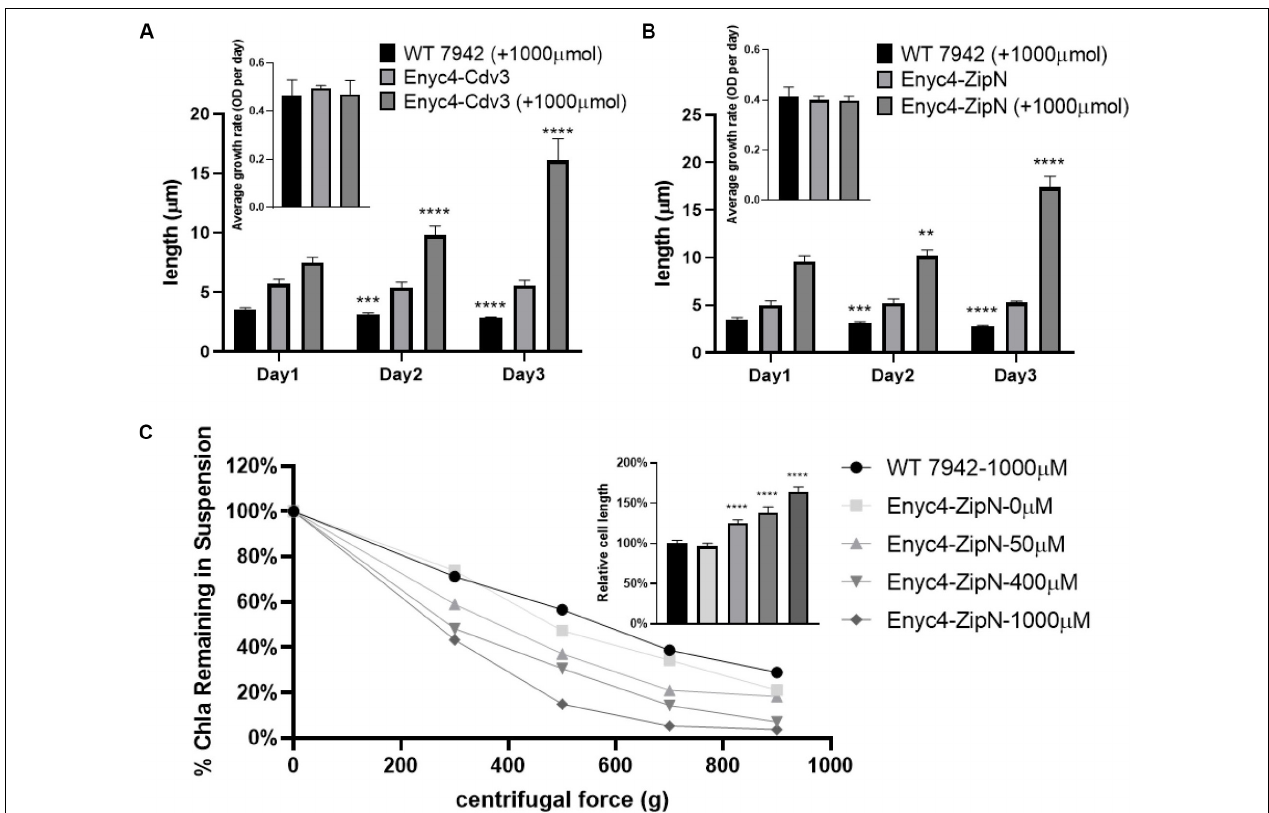
FIGURE 4 | Response of the cell lengths to theophylline induction in PCC7942 strains carrying riboswitch-regulated expression of Cdv3 and ZipN. The cell lengths of the PCC7942 mutants carrying Ptrc-ENYC4-Cdv3 (A) and Ptrc-ENYC4-ZipN (B) were calculated during 3 days cultivation with (1000 µ M) or without theophylline induction. The inset figures show the growth rates of the wild type and mutant strains during the process. The Kruskal-Wallis test in One-way ANOVA was used to analyze the significant difference of cell length at Day 2 (and Day 3) compared with that of at Day 1 in each strain. * indicates < 0.05; ** indicates < 0.01; *** indicates < 0.001; **** indicates < 0.0001. The culture of wild-type control was supplemented with 1000 µ M theophylline, which didn’t affect its growth. (C) At Day 5 of induction by theophylline, Chl a (Chlorophyll a ) contents in the supernatant of wild type and different Enyc4-ZipN cultures were analyzed after centrifugation. Ratio of Chl a content under the applied centrifugal force relative to the control condition (centrifugal force 0 g) was calculated for each culture. The embedded graph shows ratios of the cell lengths of the Enyc4-ZipN strain compared to the wild type